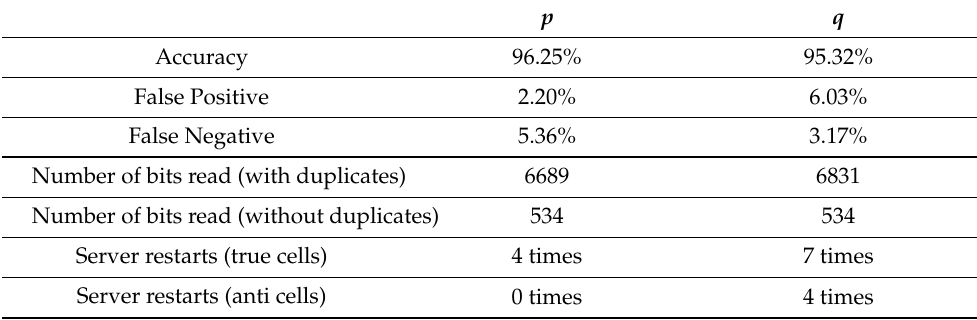
Table 3. Reading prime numbers p and q using